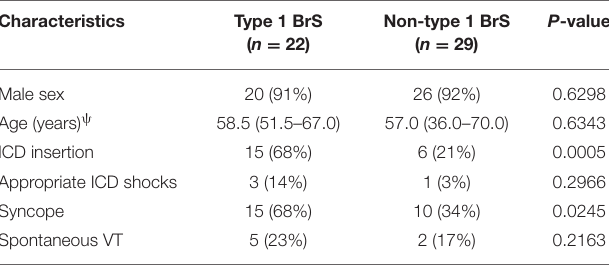
TABLE 1 | Demographic and clinical characteristics of Brugada syndrome patients included in this study ( n = 51).